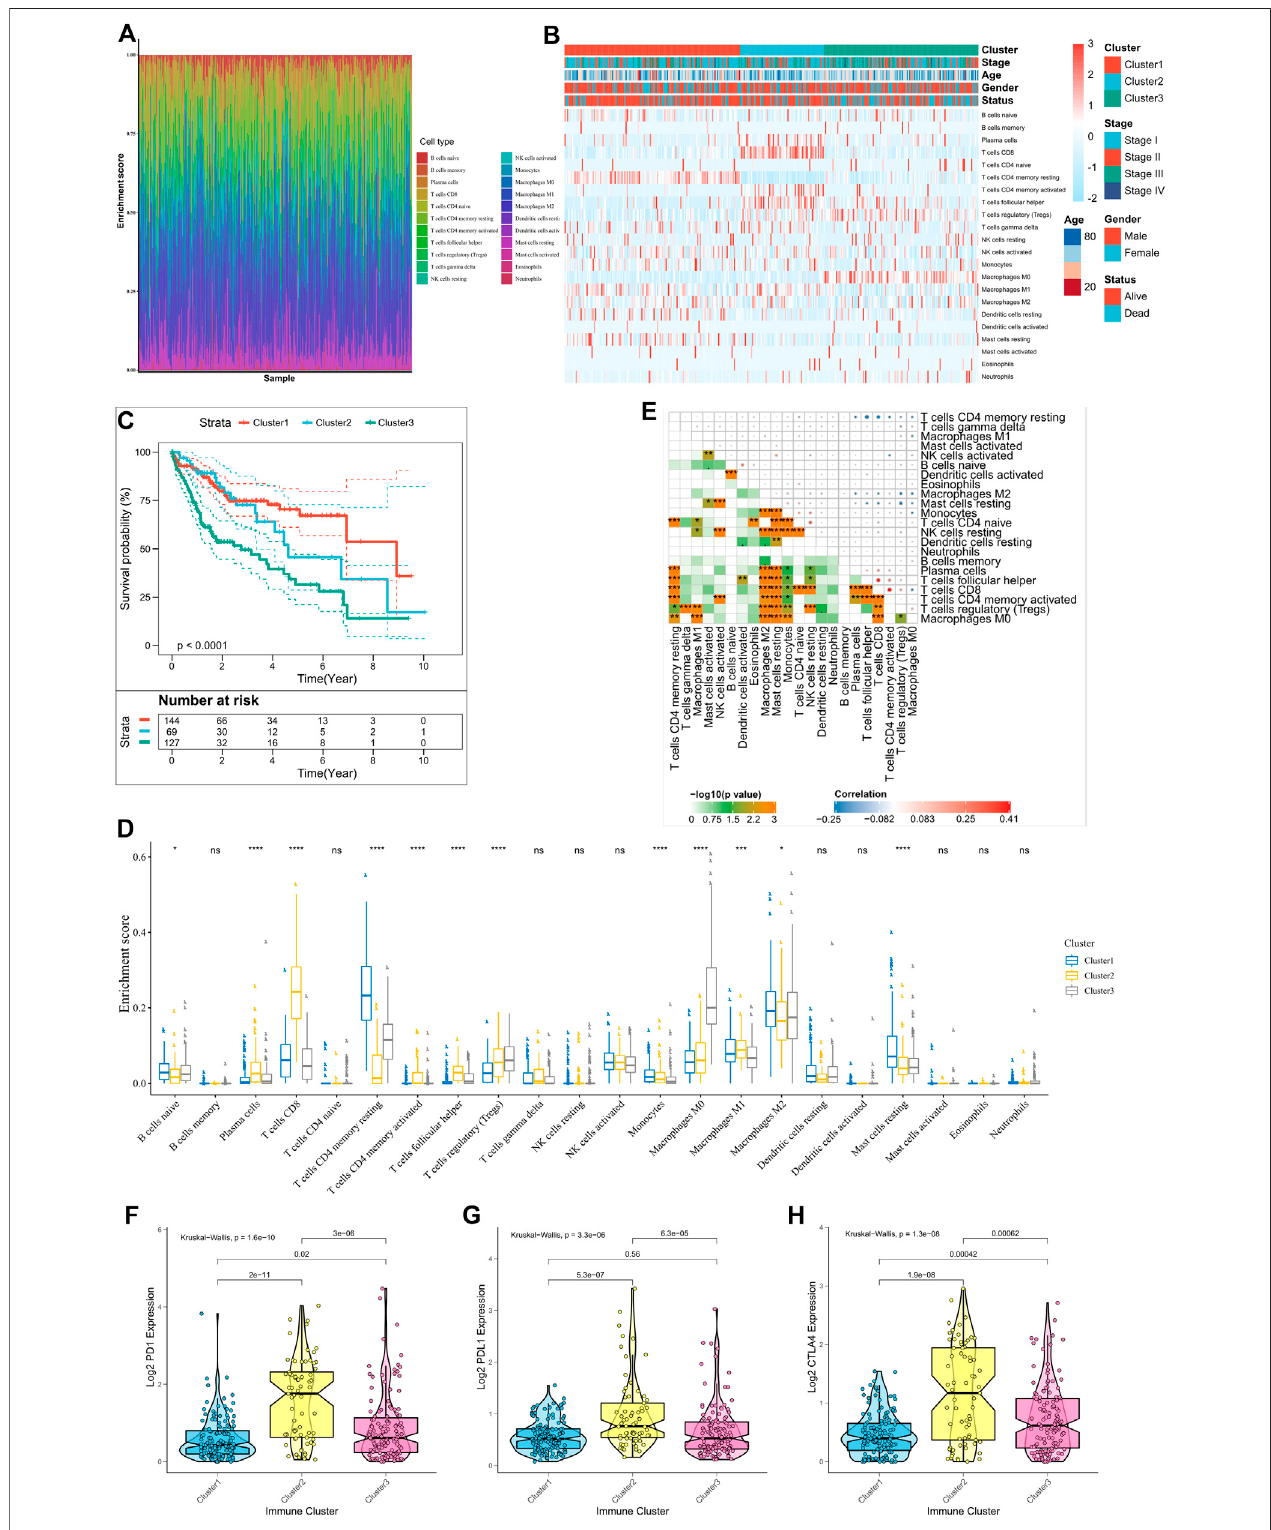
FIGURE1| ImmunelandscapeintheTCGAcohort. (A) Theimmunelandscapeof22ICIsinHCCpatients; (B) Unsupervisedclusteringoftumor-in fi ltratingimmune cells in the TCGA cohort, where rows represent tumor-in fi ltrating immune cells and columns represent samples; (C) Kaplan-Meier curves for overall survival (OS) of patients with different ICI clusters, where log-rank p (cid:1) 0.018; (D) Proportion of tumor-in fi ltrating immune cells in the three ICI clusters, where Kruskal-Wallis was used to test and compare the statistical differences of the three ICI clusters. * p < 0.05; pp p < 0.01; ppp p < 0.001; pppp p < 0.0001; (E) Cell interactions of tumor-in fi ltrating immune cell types. (F – H) Expression differences in PD-L1 (F) , PD1 (G) , and CTLA4 (H) between different ICI clusters (Kruskal-Wallis test, p < 0.0001).